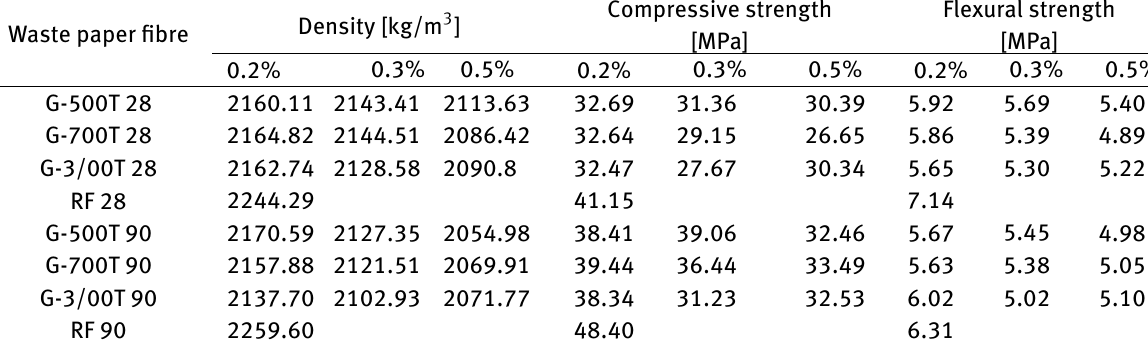
Table 2: Physical and mechanical properties of fibre cement composites and reference sample at 28 and 90 days of age